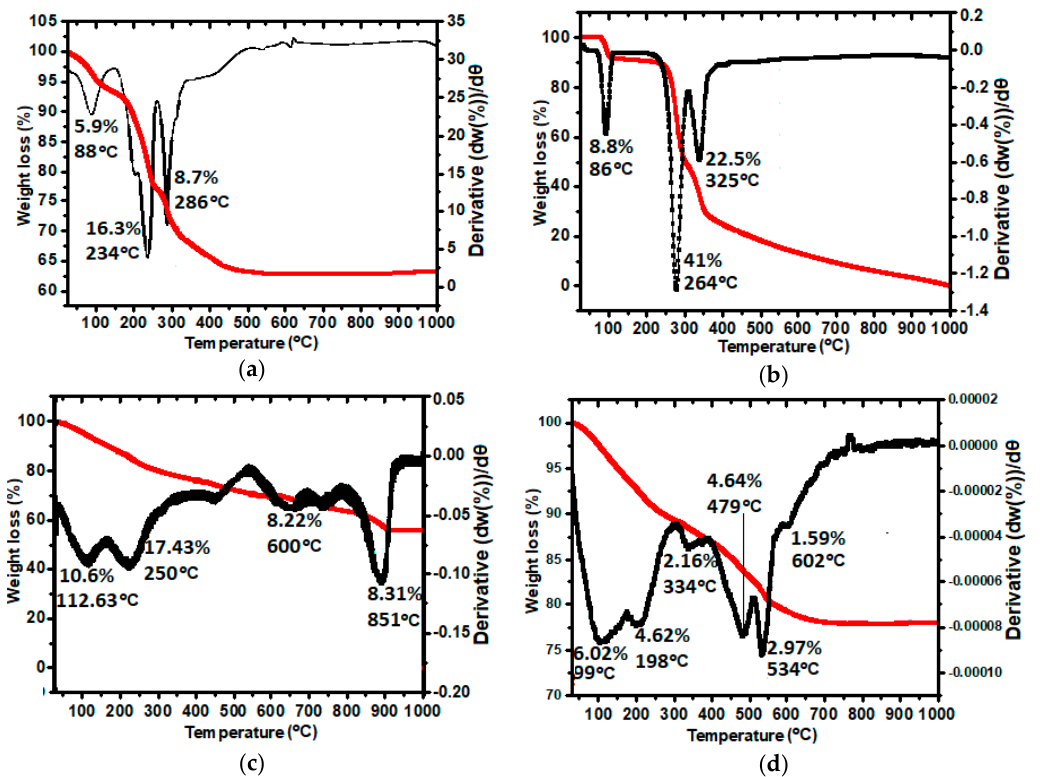
Figure 6. ( a ) Thermogravimetric and differential thermogravimetric analyses (TGA/DTG) thermograms of pure LDH; ( b ) pure gallic acid; ( c ) gallic acid-LDH/Gd nanoparticles (GAGZA); ( d ) gallic acid-LDH/Gd-Au nanoparticles (GAGZAu). Table 2. Maximum peak temperature (Tmax) decomposition temperature range (Trange) and change in mass (Delta m).